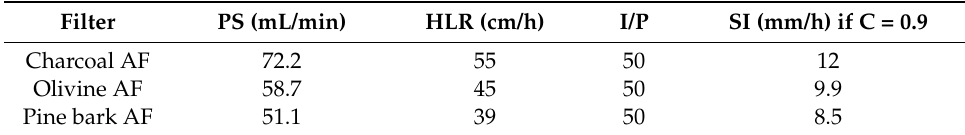
Table 6. Hydrological approach using formula 1 during the first phase of the adsorption test. PS stands for pump speed, HLR for hydraulic loading rate, I/P for impervious to pervious ratio, SI for storm intensity, and AF for amended filter. C is the empirical runoff